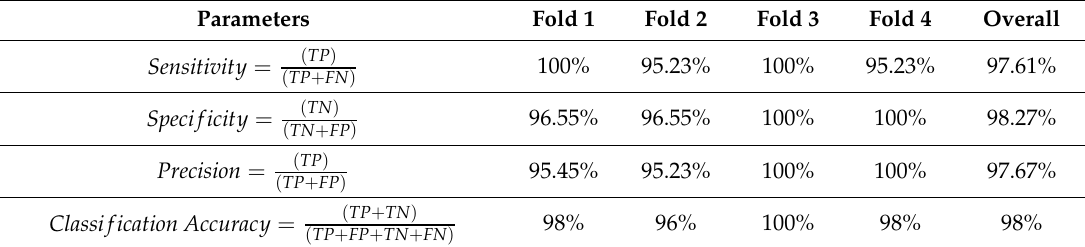
Table 25. Calculated performance parameters for ANFIS.